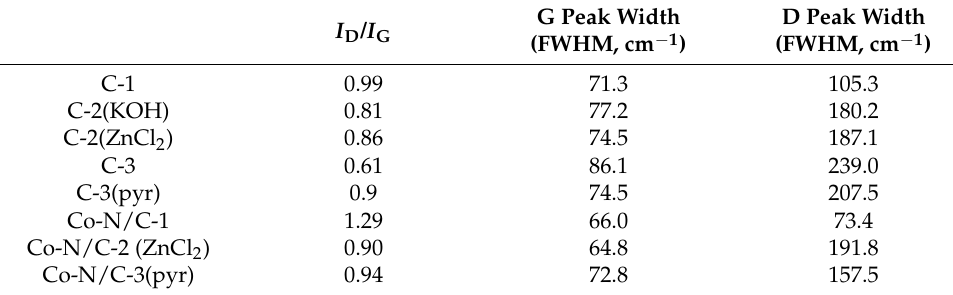
Table 4. Raman spectroscopy analysis results.